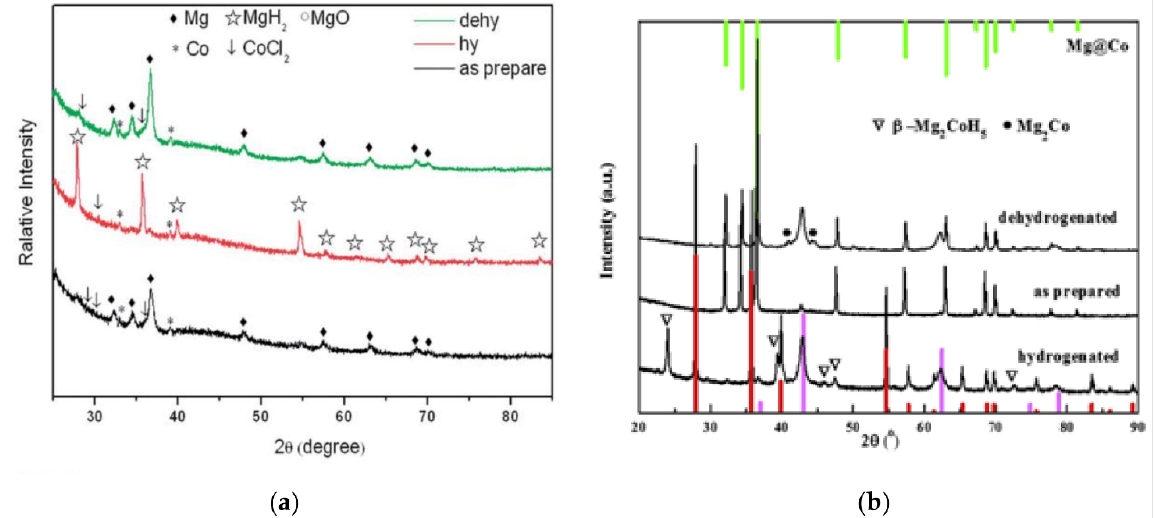
Figure 7. ( a ) The XRD profiles for the core–shell-structured Mg@Co samples in varying states (as prepared, hydrogenated, and dehydrogenated after 5 cycles). Reproduced with permission [102]. Copyright 2014, Royal Society of Chemistry. ( b ) XRD patterns of the core–shell-structured Mg@Co composites at different states (as-prepared, hydrogenated, and dehydrogenated after 10 cycles). Reproduced with permission [117]. Copyright 2017,